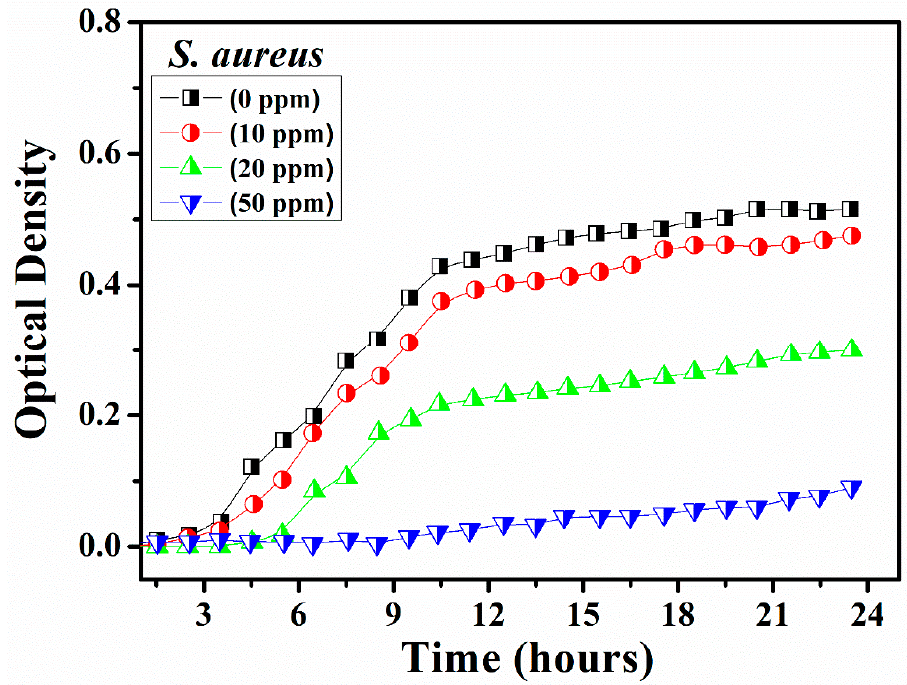
Figure 7. Optical densities as a function of time of S . aureus in the presence of CeO 2 NPs. It could be clearly observed from Figures 6 and 7 that the increasing concentration of CeO 2 NPs affects the growth of bacteria. The growth of both the bacteria viz. E. coli , as well as S. aureus, was found to be reduced with increasing concentration of CeO 2 and the highest concentration of the CeO 2 NPs (50 ppm) was determined to strongly impede the growth of all the bacterial test strains. Thereby, in particular, CeO 2 NPs produced higher toxicity to S. aureus with a fixed concentration of 50 ppm, thus the growth was inhibited much more than E. coli. Further, the antibiofilm potential of CeO 2 NPs was analyzed on these clinical isolates and data revealed the 80% and 72% inhibition of formation of biofilm in S. aureus as well as E. coli at the concentration of 50 ppm respectively (Figure 8). The nanomaterials are illustrious to exhibit long-lasting inhibitory effects on a wide spectrum of bacterial strains [41]. Various possible mechanisms have been suggested by many investigations which explain the interaction of nanomaterials with the biological macromolecules. Cerium is the most abundant lanthanide out of all the rare-earth ele- ments found in the earth’s crust (average concentration of 50 ppm) [42]. Cerium is a very reactive rare earth metal and is a strong oxidizing agent with dual oxidation states that is stabilized when associated with an oxygen ligand [43]. Generally, nanomaterials coordi- nate to electron-donating groups such as thiols, carboxylates, amides, imidazoles, indoles, and hydroxyls and deactivate cellular enzymes and DNA. They create pits in the walls of the bacterial cell leading to the enhanced permeability through the wall causing cell death [44]. The small size of CeO 2 NPs infers that it exposes a greater surface area to come in contact with the wall of the bacterial cells as a result it will exhibit a higher degree of interaction [45]. The CeO 2 NPs with a size smaller than 10 nm interact effectively with the bacteria and generate electronic effects, which boost the reactivity of NPs.